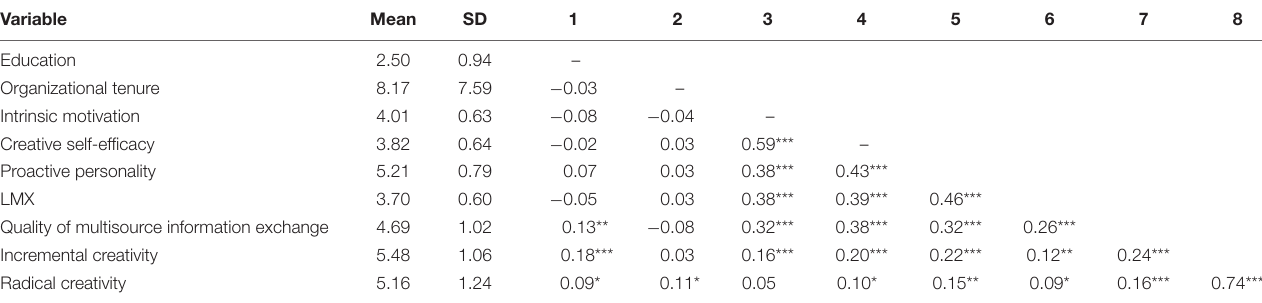
TABLE 3 | Descriptive statistics and bivariate correlations.